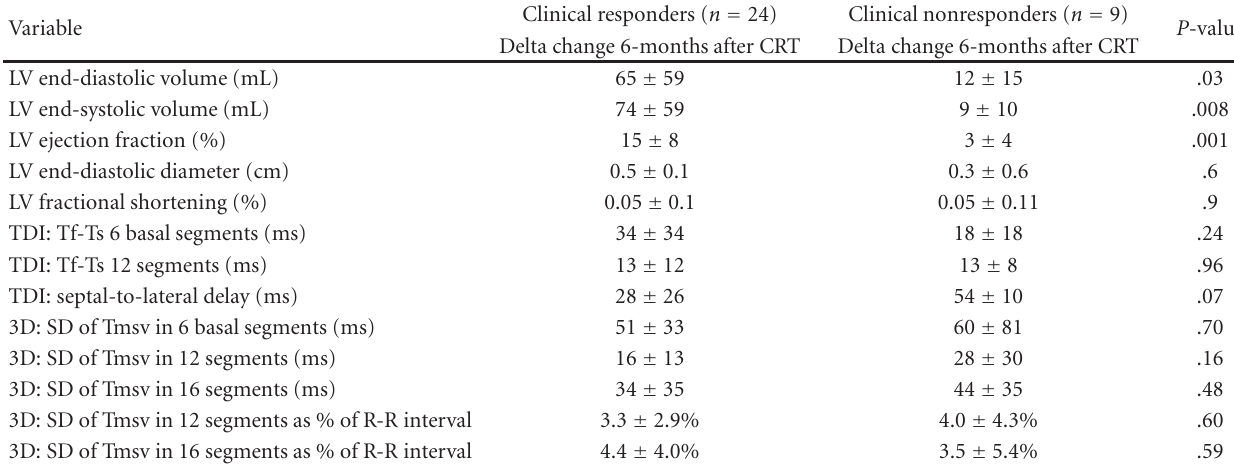
Table 2: Di ff erence in left ventricular function and dyssynchrony parameters in clinical responders versus nonresponders after long-term